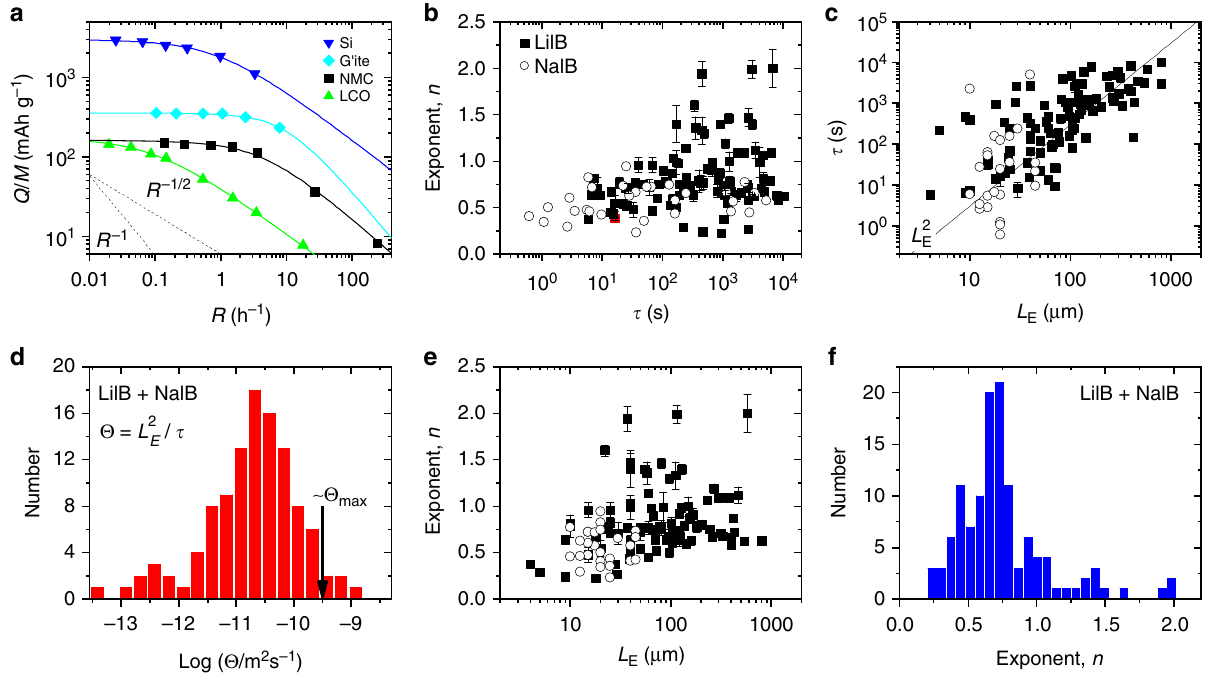
Fig. 2 Overview of literature data analysed using Eq. (2). a Four examples of speci fi c capacity ( Q / M ) versus rate data taken from the literature. These data all represent lithium ion half cells with examples of both cathodes and anodes. The cathode materials are nickel manganese cobalt oxide (NMC, ref. 39 ) and lithium cobalt oxide (LCO, ref. 34 ) while the anode materials are silicon (Si, ref. 43 ) and graphite (G ’ ite, ref. 51 ). In each case the solid lines represent fi ts to Eq. (2), while the dashed lines illustrate R − 1 and R − 1/2 behaviour. b Eq. (2) was used to analyse 122 capacity-rate data sets from 42 papers describing both lithium ion (LiIB) and sodium ion (NaIB) half cells. The resultant n and τ data are plotted as a map in ( b ) (this panel does not include work which varies the content of conductive additive). c Characteristic time, τ , plotted versus electrode thickness, L E for NaIBs and LiIBs. The line illustrates L 2 behaviour. d E = τ for NaIBs and LiIBs (log scale). The arrow shows the predicted maximal value of Θ . e Histogram ( N = 122) showing frequency of occurrence of Θ ¼ L 2 E Exponent, n , plotted versus electrode thickness, L E , for NaIBs and LiIBs. f Histogram ( N = 122) showing frequency of occurrence of n for NaIBs and